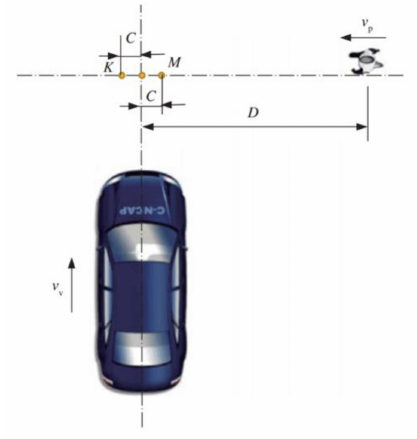
Figure 1. The sketch of CVFA-50 test